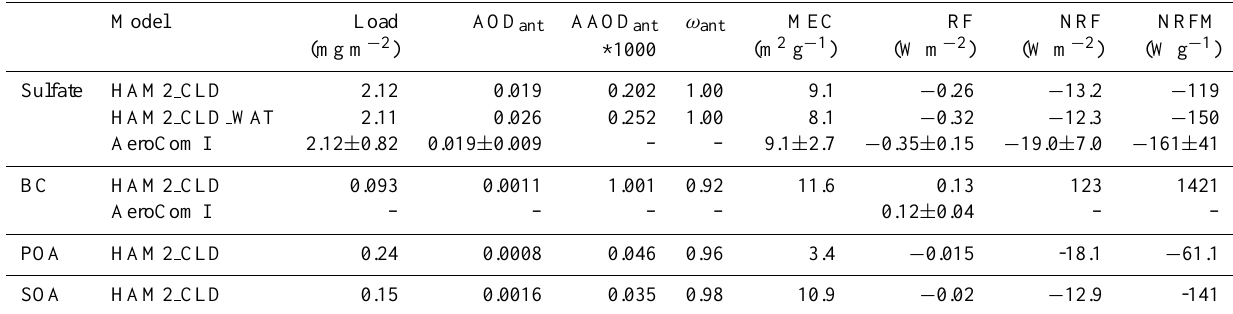
Table 10. Radiative properties and anthropogenic (direct) shortwave forcing of individual aerosol species. AOD ant , AAOD ant and ω ant are the optical depth, absorption optical depth and single scattering albedo of anthropogenic aerosols. MEC stands for dry mass extinction coefficient, RF for radiative forcing. NRF is the normalized RF per unit AOD. NRFM is the raditive forcing efficiency per unit aerosol load. The AeroCom I multi-model mean and standard deviation are from Schulz et al. (2006). Further details can be found in Sect. 5.5.